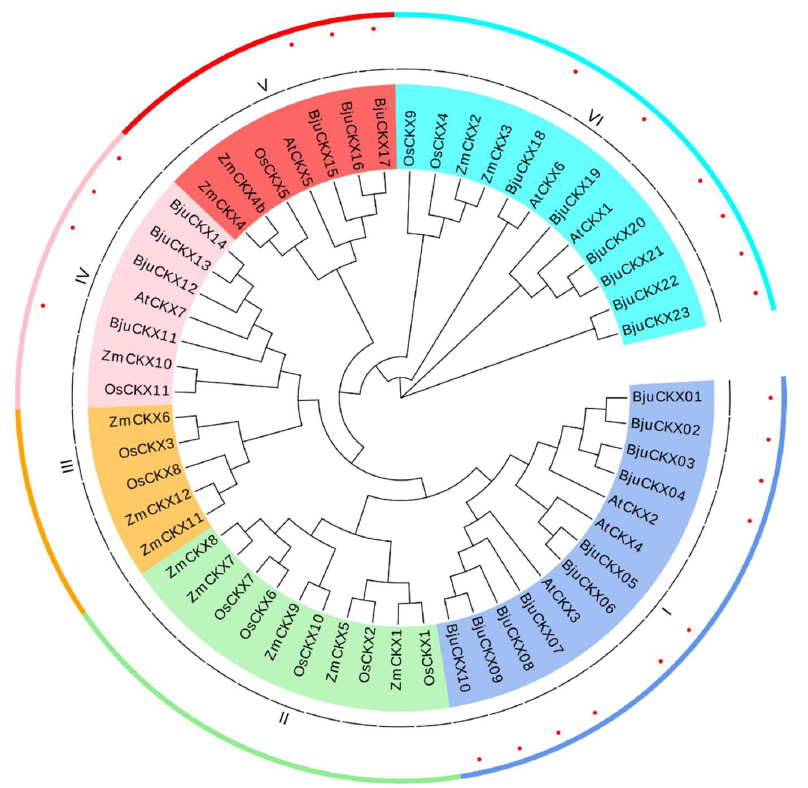
Figure 1. Phylogenetic tree of CKX gene families in B. juncea , Arabidopsis , Oryza sativa , and Zea mays . The tree was generated based on protein sequences when aligned with Clustal W, following the neighbor-joining method. CKX proteins were divided into six subgroups (I, II, III, IV, V, VI), and each color group represented a